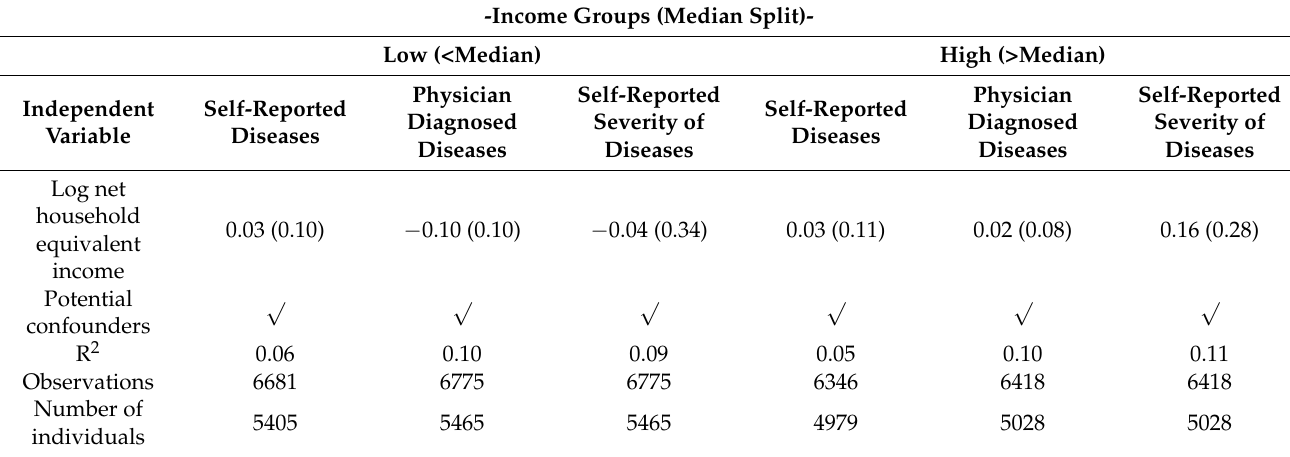
Table 6. Determinants of morbidity. Results of linear fixed-effects regressions (stratified by income, median